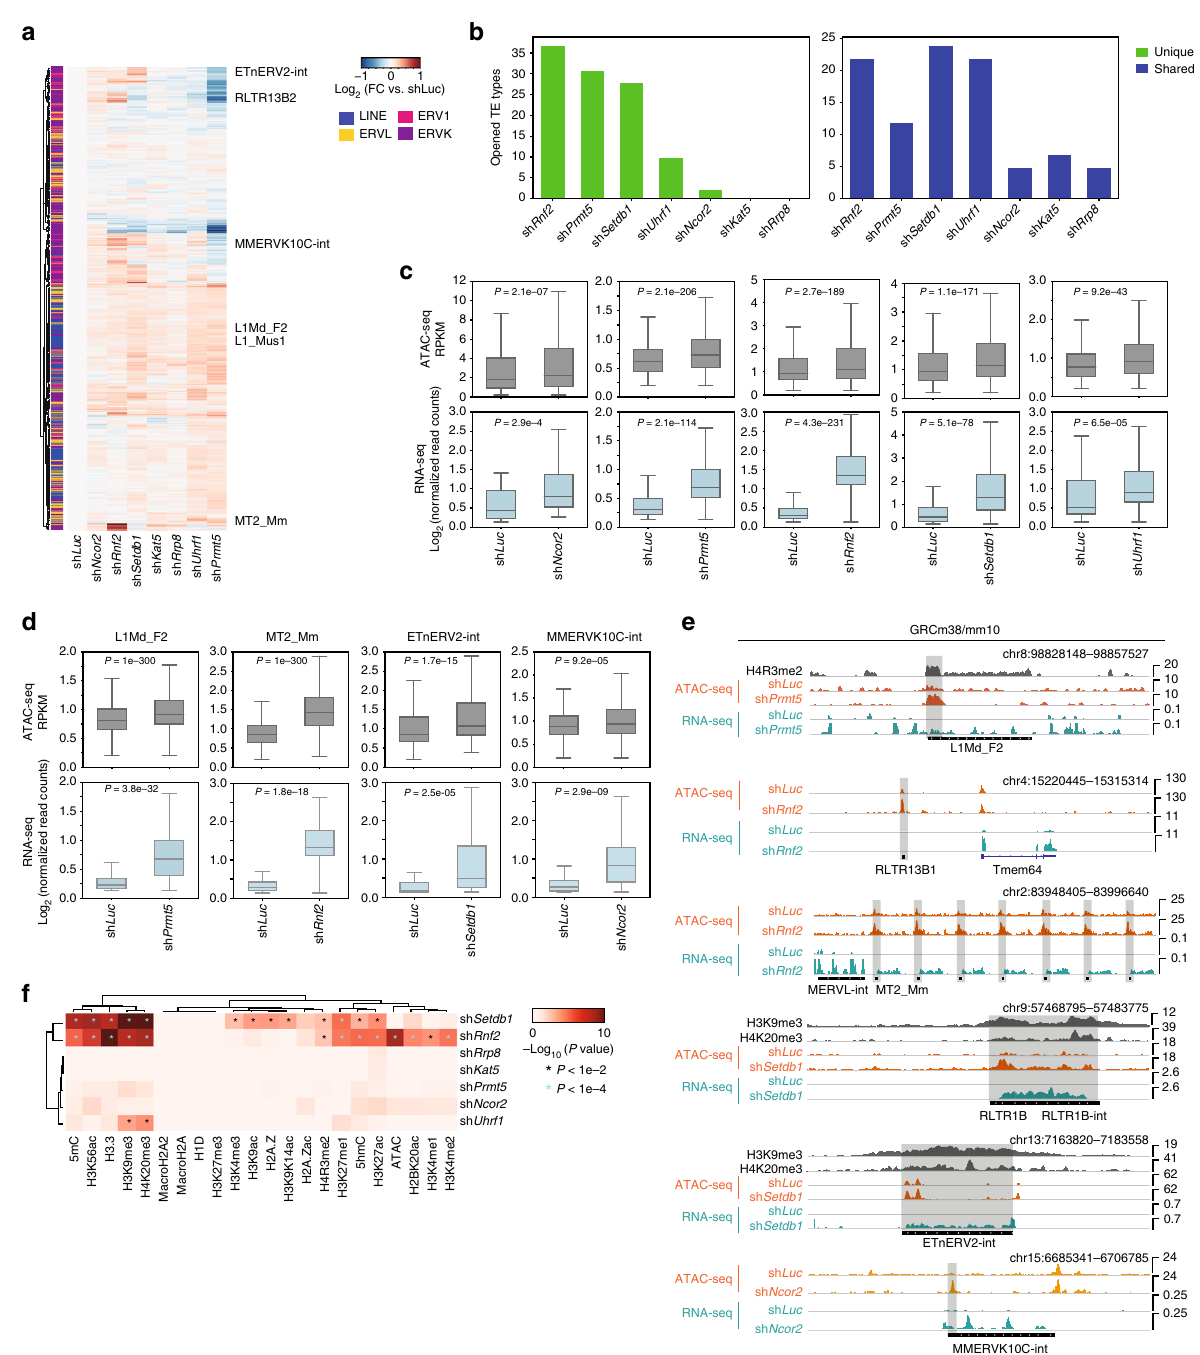
Fig. 4 Loss of CMs opens chromatin at speci fi c TEs. a Heatmap of the fold-changes in chromatin accessibility (measured by ATAC-seq) at TE types. The list of TE types are those that have 20% more or 20% less open or closed chromatin. Selected TE types are indicated, and the full table of all TE chromatin changes is in Supplementary Data 5. b Bar chart of the number of TE types that acquire open chromatin in a unique shRNA knockdown (left), or in more than one shRNA knockdown (right). c Boxplots showing the relationship between chromatin (ATAC-seq, top rows) and expression (RNA-seq, bottom rows). The boxplots contain all TE types that acquire open chromatin, for the selected shRNA knockdowns. P values were derived from a Mann – Whitney U test. d Boxplots of the levels of ATAC-seq (top rows, dark gray) and RNA-seq (bottom rows, light gray) for selected TE families for the indicated CM knockdown, for the indicated type of TE. P values were from a Mann – Whitney U test. e Example genome views of individual genomic TEs showing speci fi c chromatin marks, expression (RNA-seq), and chromatin accessibility (ATAC-seq). The examples show TEs that acquire open chromatin and expression in the indicated shRNA knockdown. Examples include the LINE1 elements (L1Md_T, L1Md_A), ERVL (MERVL-int), MT2_Mm, ERVKs (RLTR13B1, ETnERV2-int, and MMERVK10C-int). f Enrichment of chromatin marks at TE types that become open in response to the indicated shRNA knockdown. Signi fi cance is derived from a Fisher exact test, P < 0.01 and is indicated with a asterisk. For the boxplots, the midline indicates the median, boxes indicate the upper and lower quartiles and the whiskers indicate 1.5*interquartile